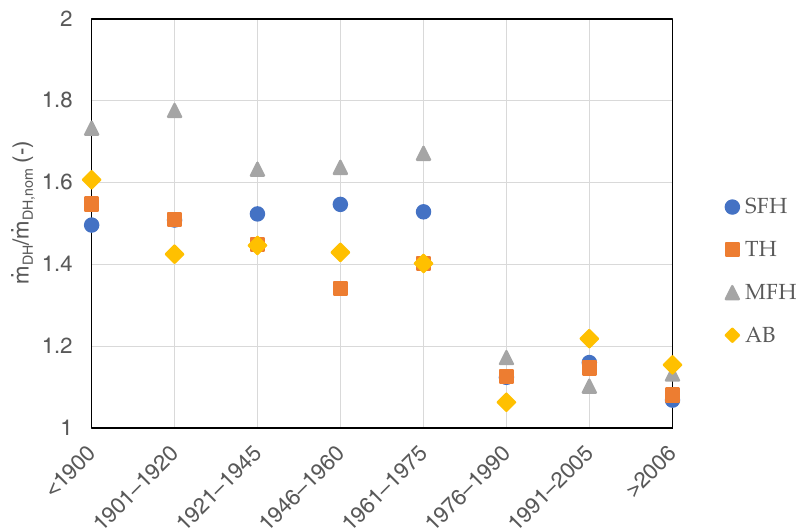
Figure 9. Ratio between the secondary flow rate need with decreased DH temperature ( θ DH = 88 ◦ C) and the original design flow rate ( θ DH = 115 ◦ C) for the different types of buildings as a function of construction period.